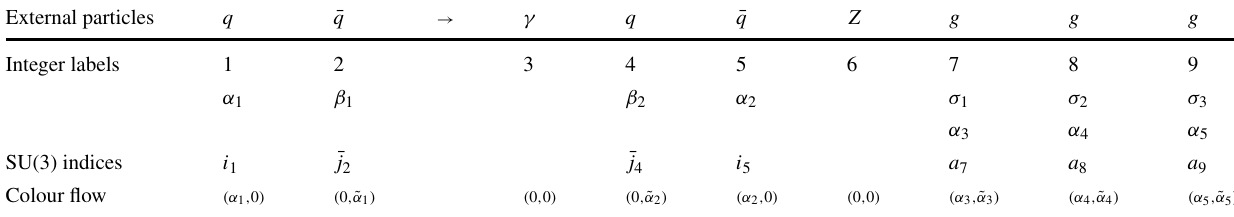
For the process considered in the table, q ¯ q → γ q ¯ qZggg , we have (α 7 , 8 , 9 ) . The last row illustrates the notation of the colour-flow basis. ( ¯ j β ) . k l